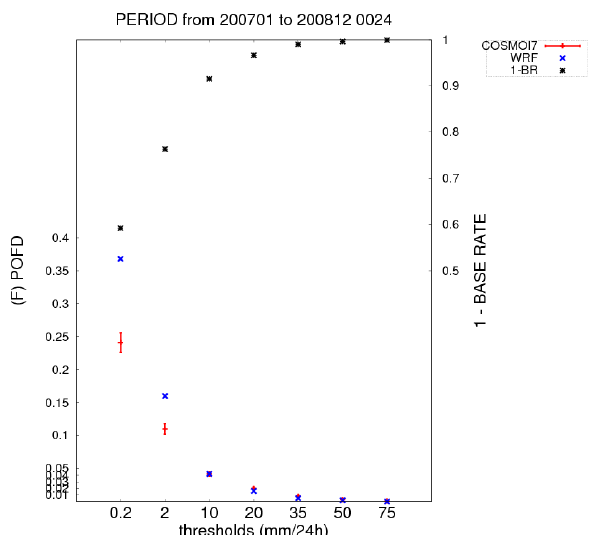
Fig. 5. Long-period verification: POFD vs. increasing thresholds for the first day of forecast. The dashed red lines and the blue dag- gers represent COSMO-I7 and WRF, respectively. The Base Rate (stars) is plotted for each threshold.